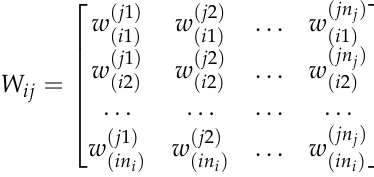
Figure 5. ANP Hierarchy.